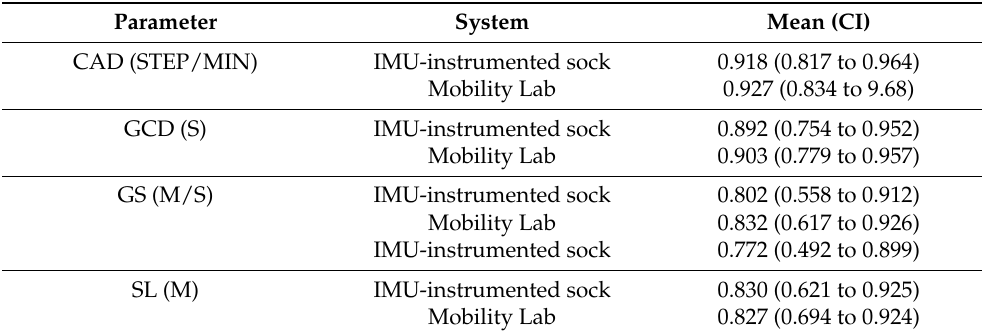
Table 3. Intersession reliability of the spatio-temporal parameters estimated by the TEADRIP algo- rithm applied to the IMU-instrumented sock and those estimated by the Mobility Lab system for overground walking. Intra Class Correlation Coefficient (ICCs) and their 95% CI for the